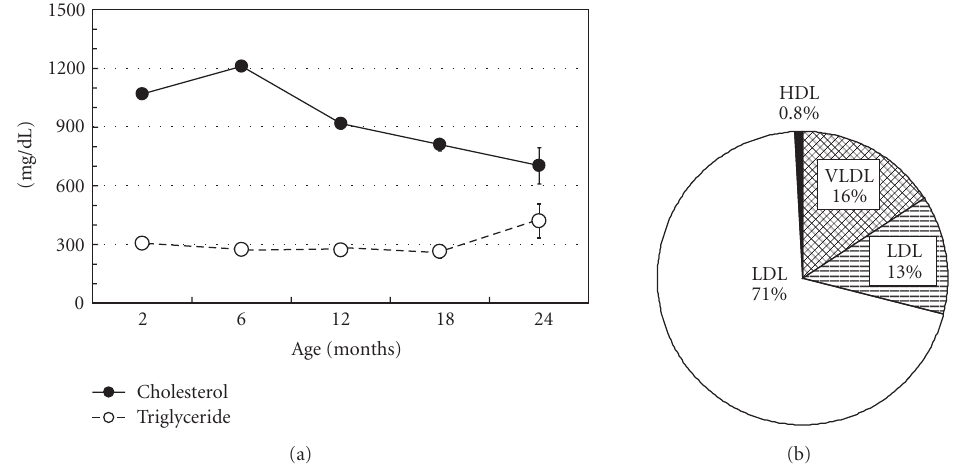
Figure 1: Changes in the serum lipid levels of WHHLMI rabbits with age (a), and the distribution of cholesterol in lipoproteins (b). Data are represented as the mean ± standard error of the mean. The serum cholesterol levels at 12 months old were about 900mg/dL. Excess LDL cholesterol is atherogenic and HDL has antiatherogenic function. In WHHL rabbits, LDL is accumulated in the plasma and HDL-cholesterol is low, less than 20mg/dL. The serum cholesterol levels decrease gradually with aging.